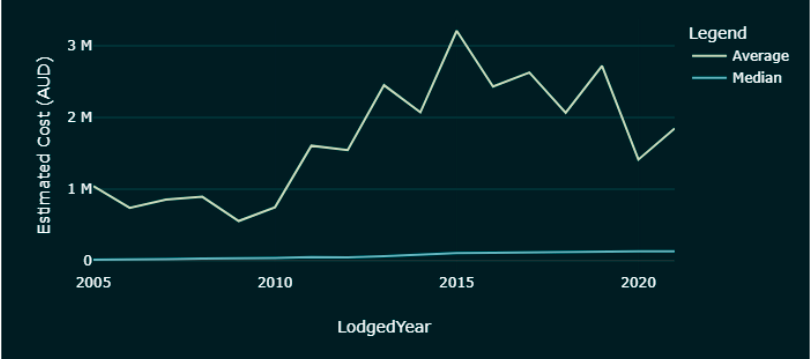
Figure 26. Average compared to median estimated cost of determined DAs lodged between 2005–2021.